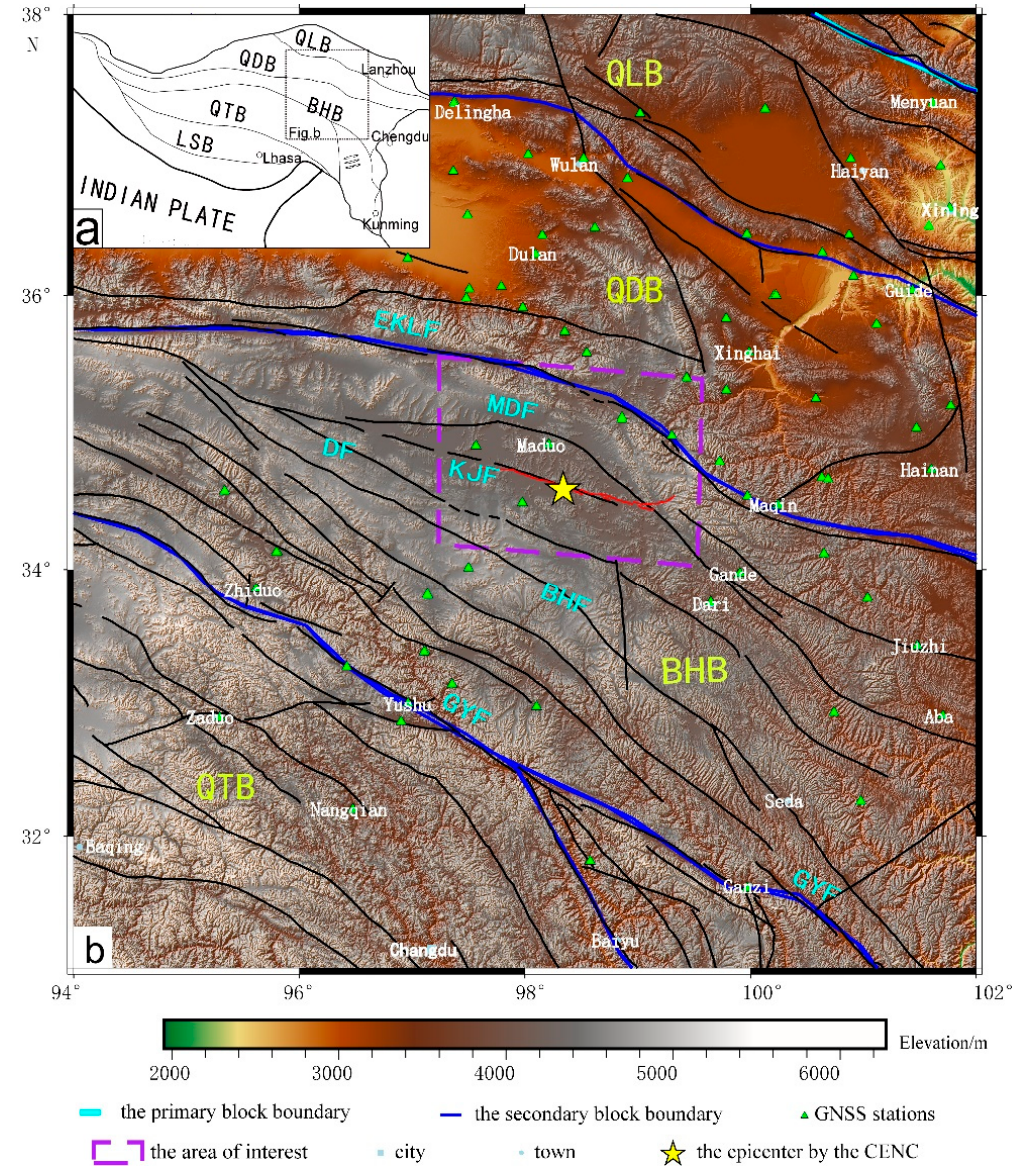
Figure 1. The tectonic location of the 2021 Maduo M S 7.4 earthquake and distribution of the used GNSS station in the study area. ( a ) is the tectonic unit of the Qinghai-Tibet Plateau and ( b ) is the specific tectonic location and active fault of the black box in ( a ): the green-yellow font represents the abbreviated name of the secondary tectonic block, the light blue font represents the abbreviated name of the main fault, the cyan line represents the primary block boundary, the blue line represents the secondary tectonic block boundary, and the black line is the active fault divided by Deng et al. [44]. The yellow pentagram represents the epicenter location of the 2021 Maduo MS7.4 earthquake according to the China earthquake networks center (CENC), the green triangle represents the GNSS stations near the area of interest, which shows some stations overlap because of close ranges, the purple dotted frame is the area of interest, and the red line is the surface rupture caused by the earthquake, the light blue square and dot are city and town, respectively. BHB—Bayan Har Block,